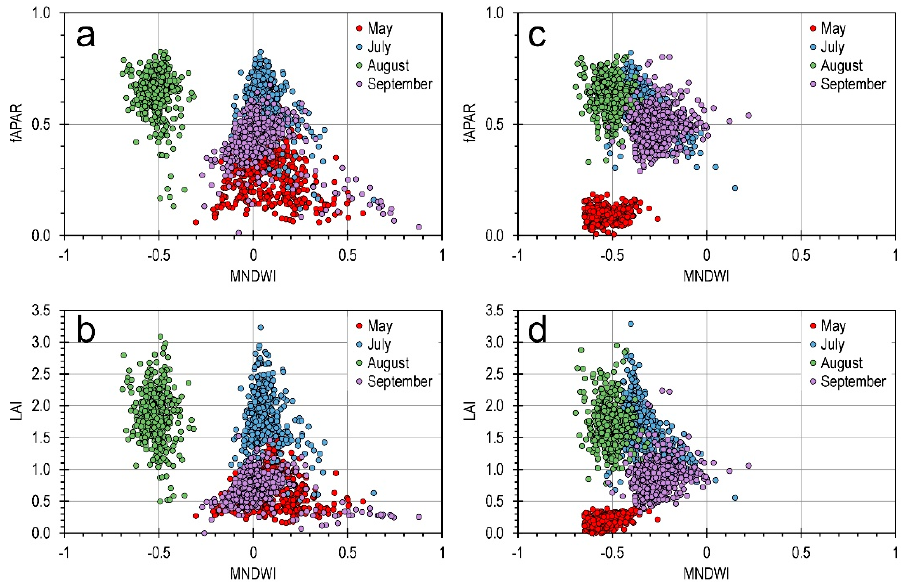
Figure 11. Comparison of Herbaceous/Meadow class LAI and fAPAR vs. MDNWI indices for the 2018 ( a , b ) and 2019 ( c , d ) growing seasons. See Figure 9 for definition of acronyms.